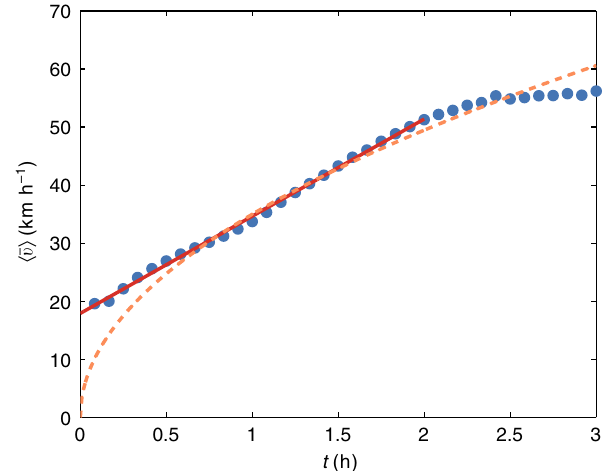
Figure 2 | Acceleration of private transportation. Empirical average speeds (blue dots) versus the duration of the trip for our GPS data set. The red solid line represents a constant average acceleration (cid:2) v h i¼ v 0 þ at with v 0 ¼ 17.9kmh (cid:2) 1 and a ¼ 16.7kmh (cid:2) 2 . For t 4 2h the speed reaches a saturation at (cid:2) v h i E 55kmh (cid:2) 1 imposed by the finite number of layers (see Methods section and Supplementary information). The dashed line represents the best fit with (cid:2) v j jh i p t 1/2 (as predicted by the simple random model equation (1) with uncorrelated